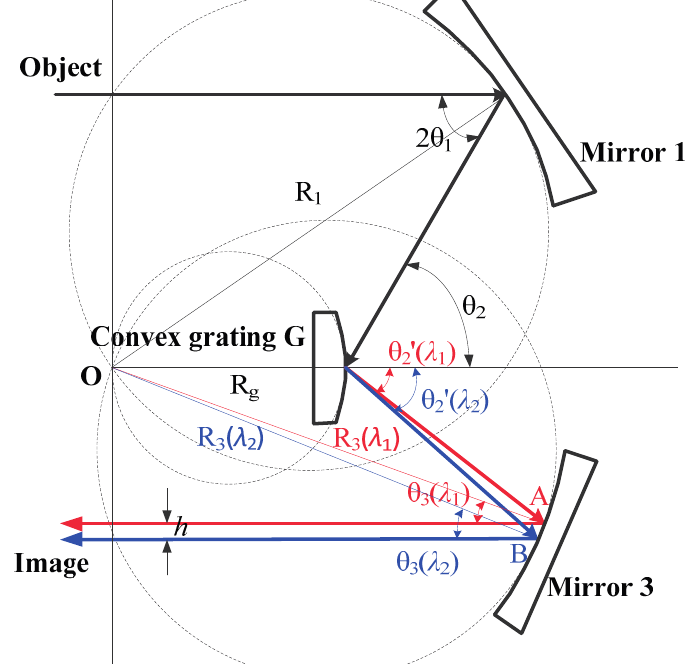
Figure 4. An Offner imaging spectrometer with Rowland circle